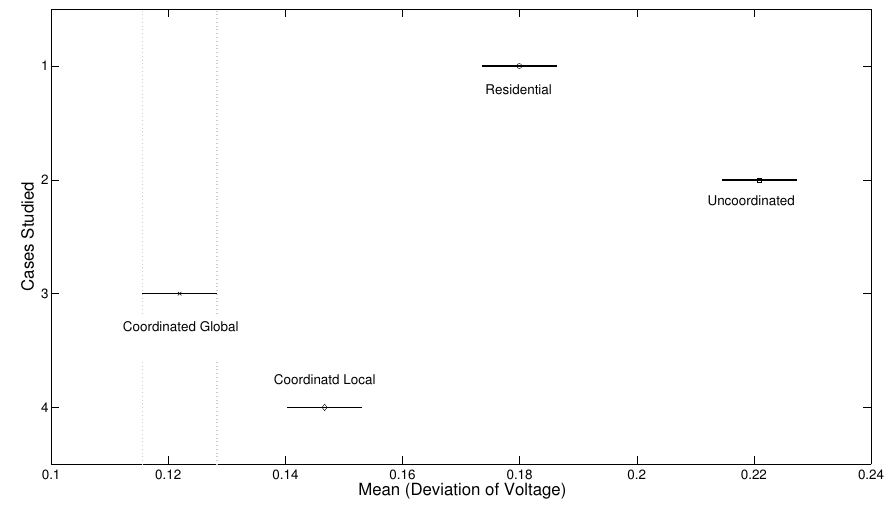
Figure 24. ANOVA results on the deviation of voltage from average daily voltage for the system.